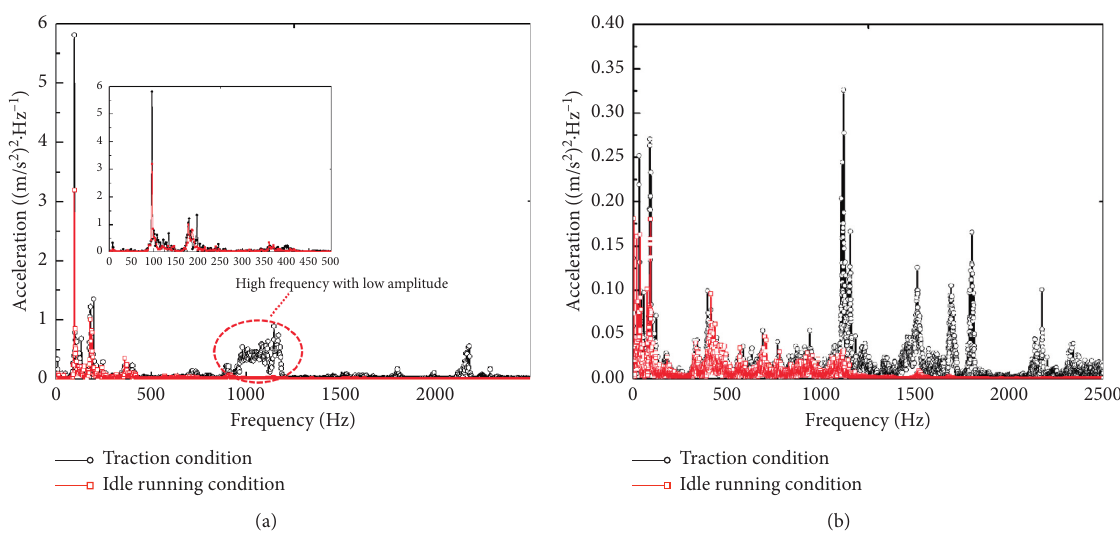
Figure 7: (a) Acceleration PSD of the motor (vertical). (b) Acceleration PSD of the motor